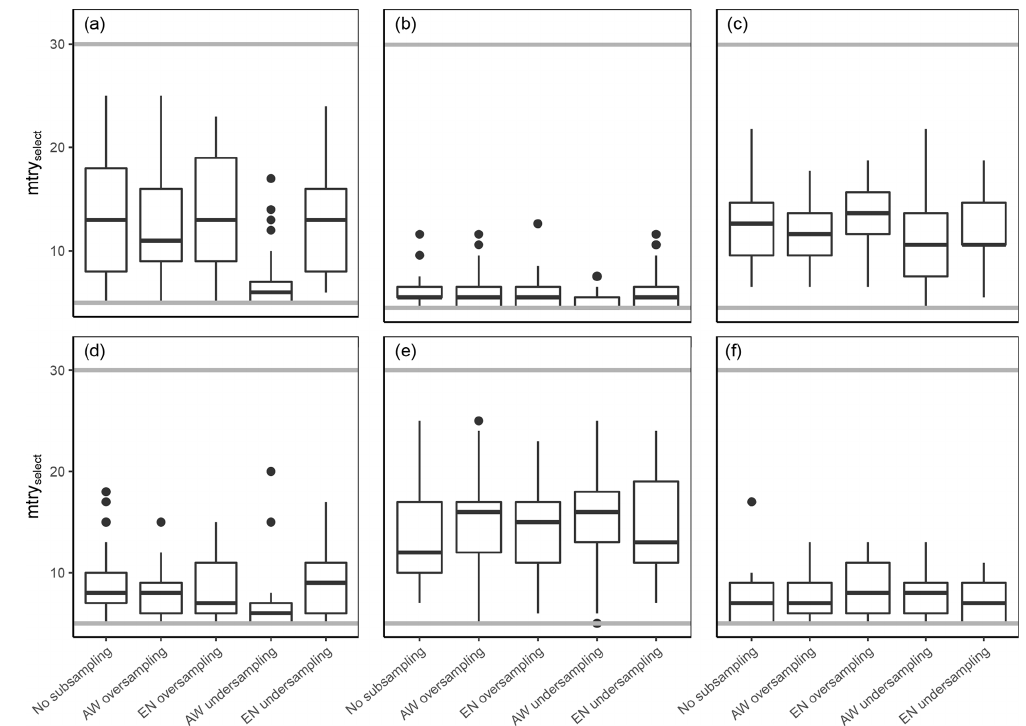
Figure 9. Results of the model tuning procedure to find the best-performing mtry values (mtry select ) under different subsampling approaches. Panels (a) , (b) , and (c) show the results of the clay, silt, and sand models at 10cm depth, while panels (d) , (e) , and (f) show the same texture classes at 70cm depth. Grey lines correspond to the tested mtry parameter range.